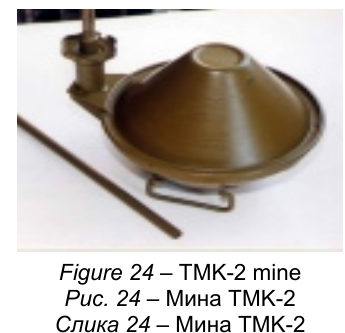
Figure 24 – TMK-2 mine Рис . 24 – Мина TMK-2 Слика 24 – Мина